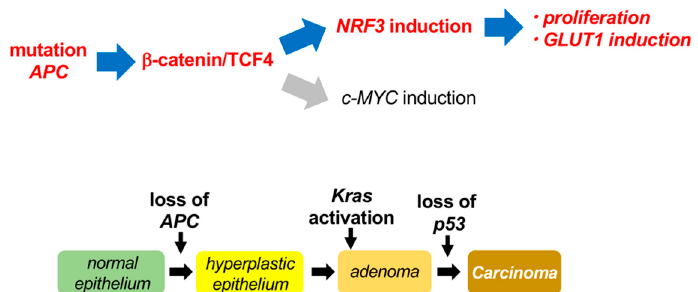
Figure 7. Schematic model of the β -catenin / TCF4-NRF3 axis in cancer cells. APC gene deletion is a